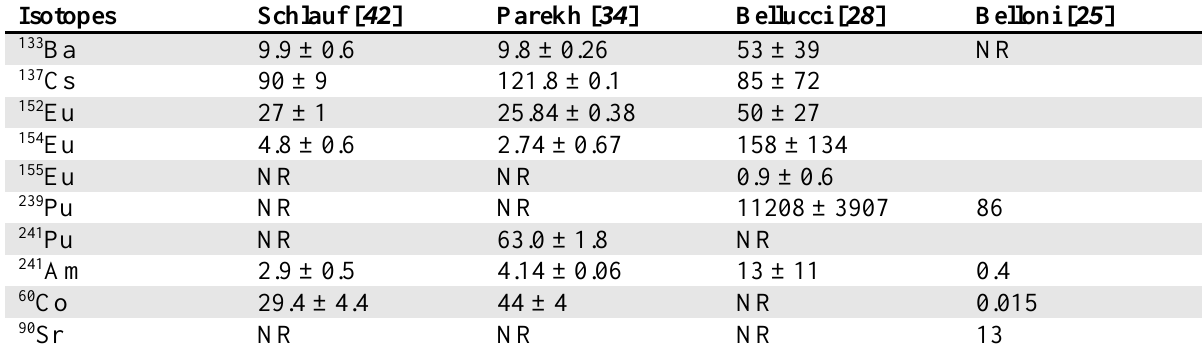
Table 3. Reported Radioactive Nuclides in Trinitite Activities in (Bq/g) for Specific Isotopes of